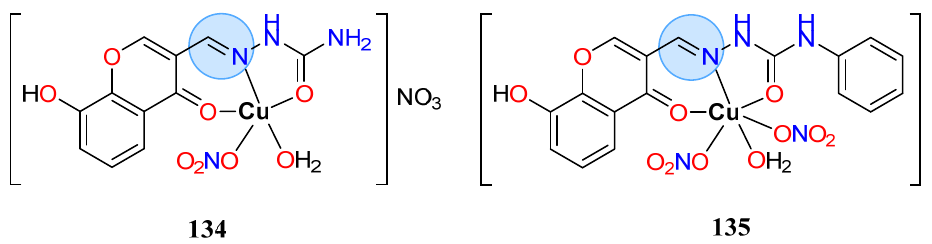
Figure 66. Cu(II) complexes with an ONO semicarbazone SB ligand studied for their antimicrobial activity.